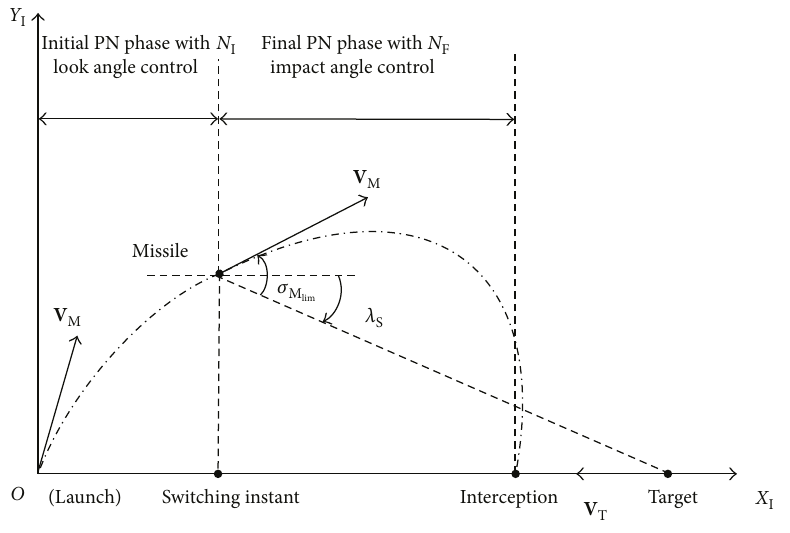
Figure 2: Two-phased guidance